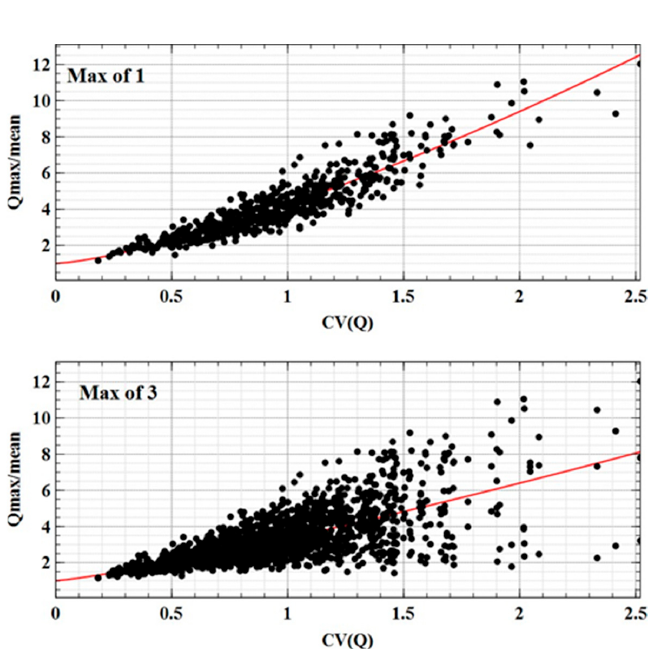
Table 2. Coefficients of non-linear interpolation from Figure 5.